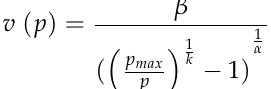
Table 7. Fitting parameters of four power curve methods and standard deviation (STD).